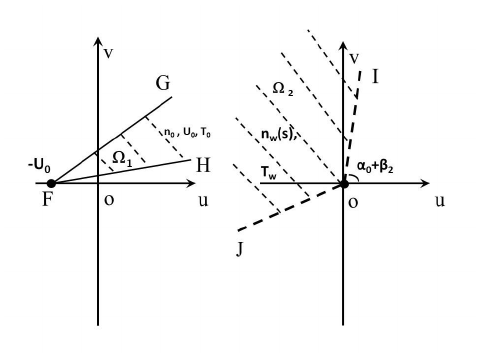
Ω 1 is for the free jet,